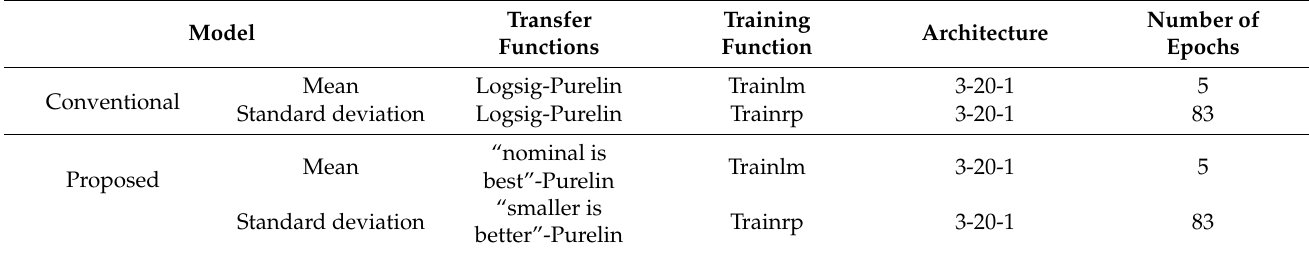
Table 1. Feed-forward NNs information used to estimate DR